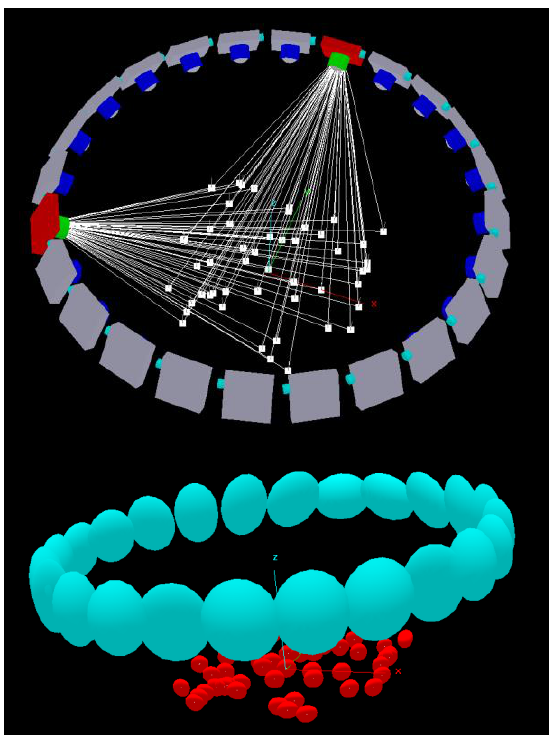
Figure 7. 3D view for a closed sequence around a flat object.